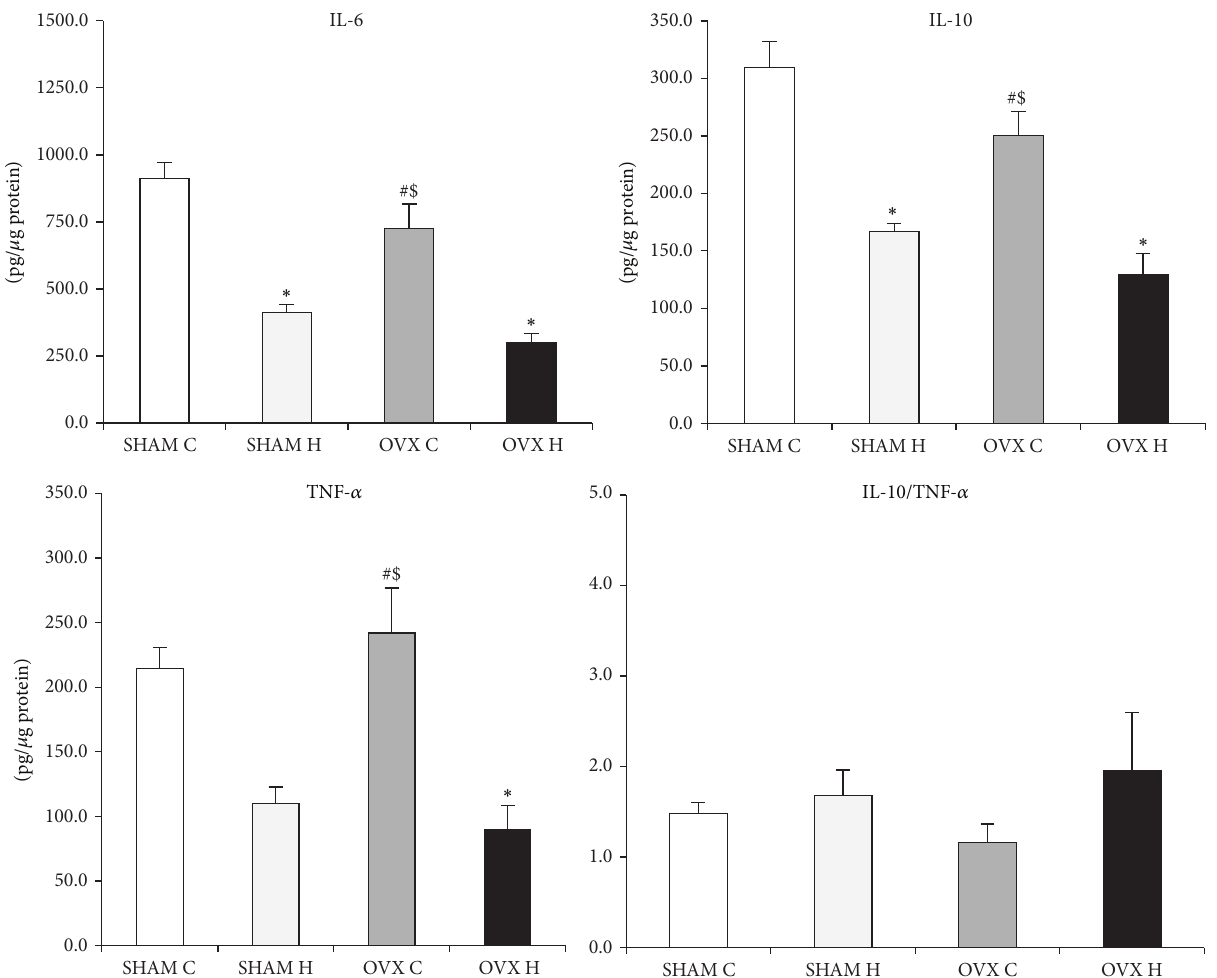
Figure 4: Mesenteric adipose tissue cytokines content of studied rats groups: (SHAM C) sham group treated with control diet; (SHAM H) sham group treated with hyperlipidic diet; (OVX C) ovariectomized group treated with control diet; (OVX H) ovariectomized group treated with hyperlipidic diet. The numbers of samples varied between six and eight. ∗ 𝑃 < 0.05 as compared to the SHAM C; # 𝑃 < 0.05 as compared to OVX H; $ 𝑃 < 0.05 as compared to SHAM